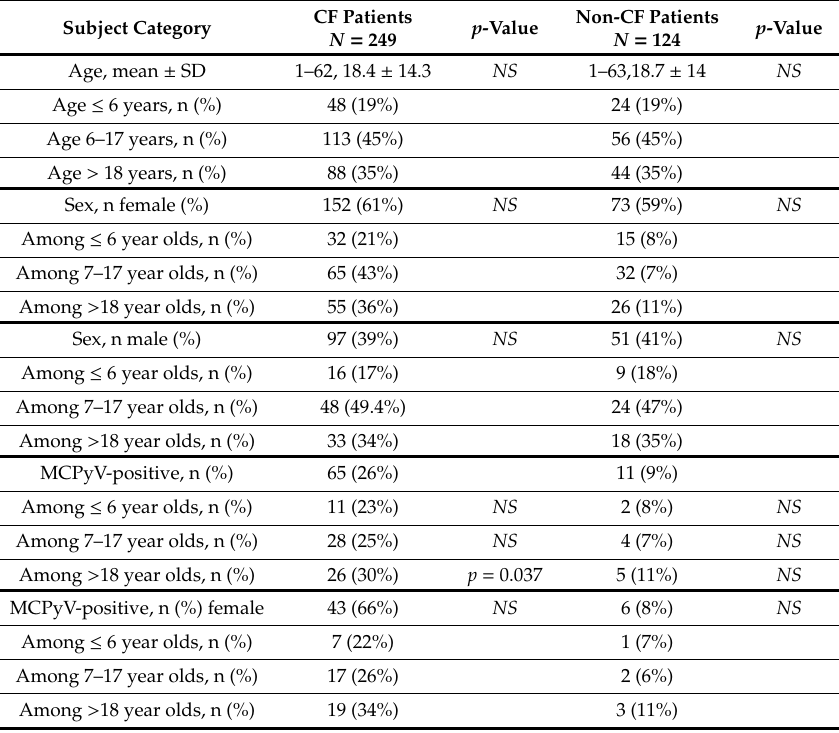
Table 1. MCPyV DNA detection in the enrolled CF patients and in non-CF